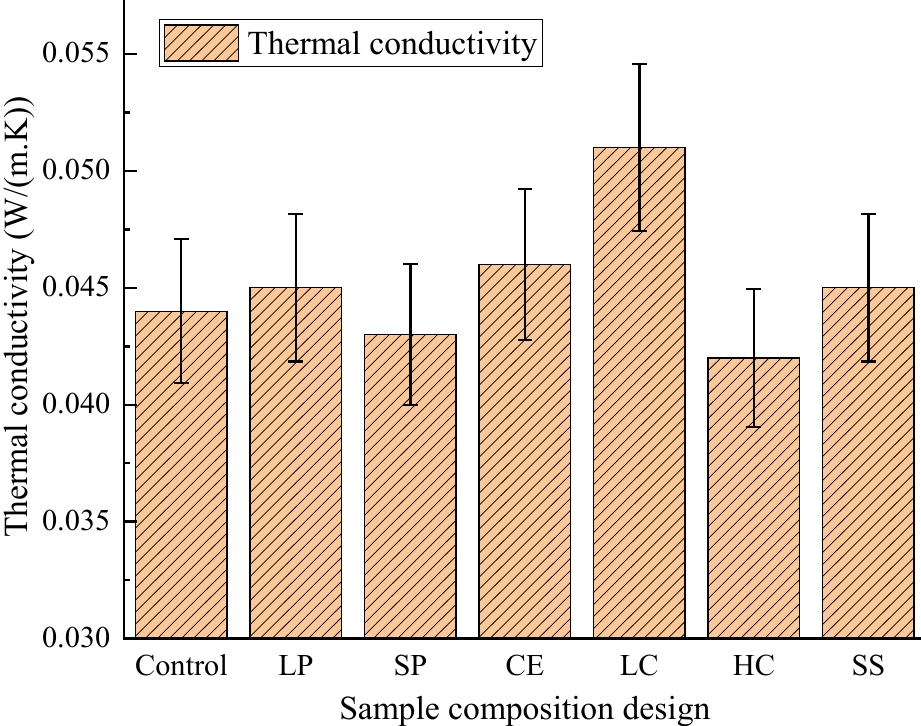
Figure 6. The results of thermal conductivity.